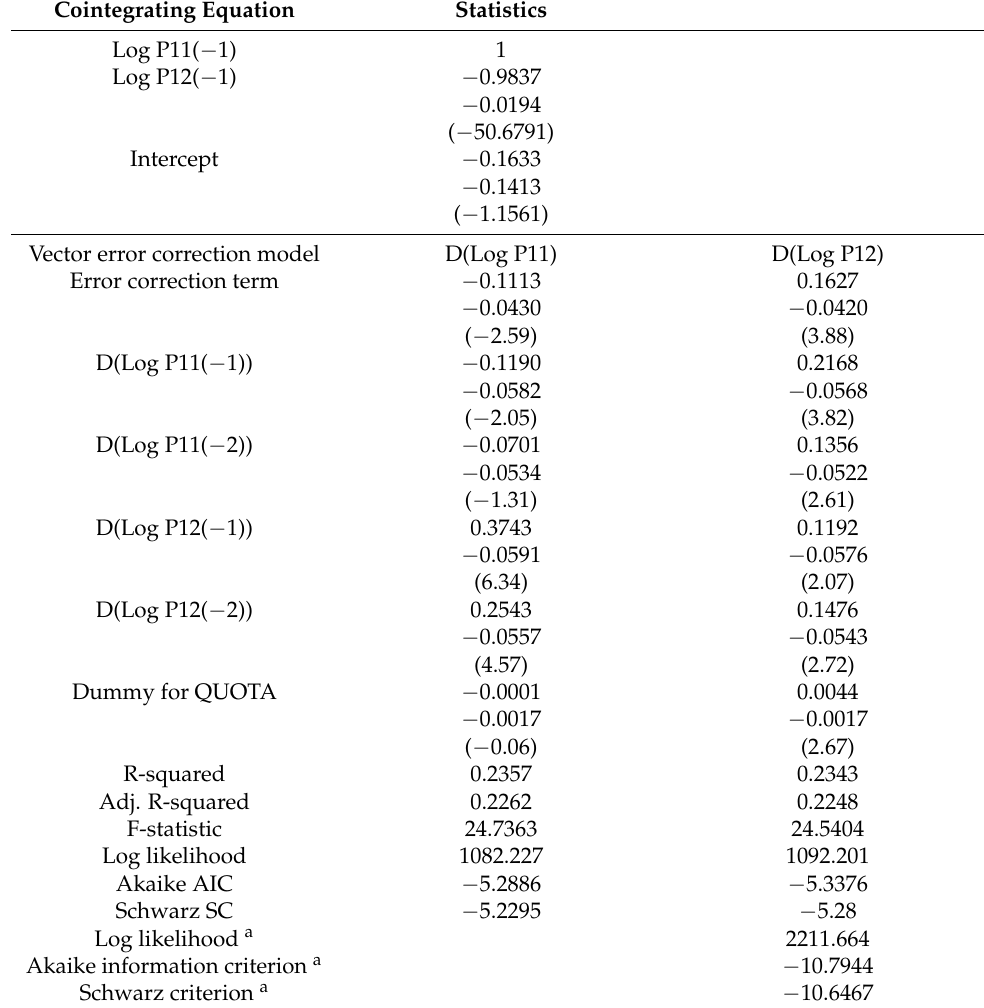
Table 5. Cointegrating equation and Vector Error Correction (VEC) model for butter prices in the Central region in